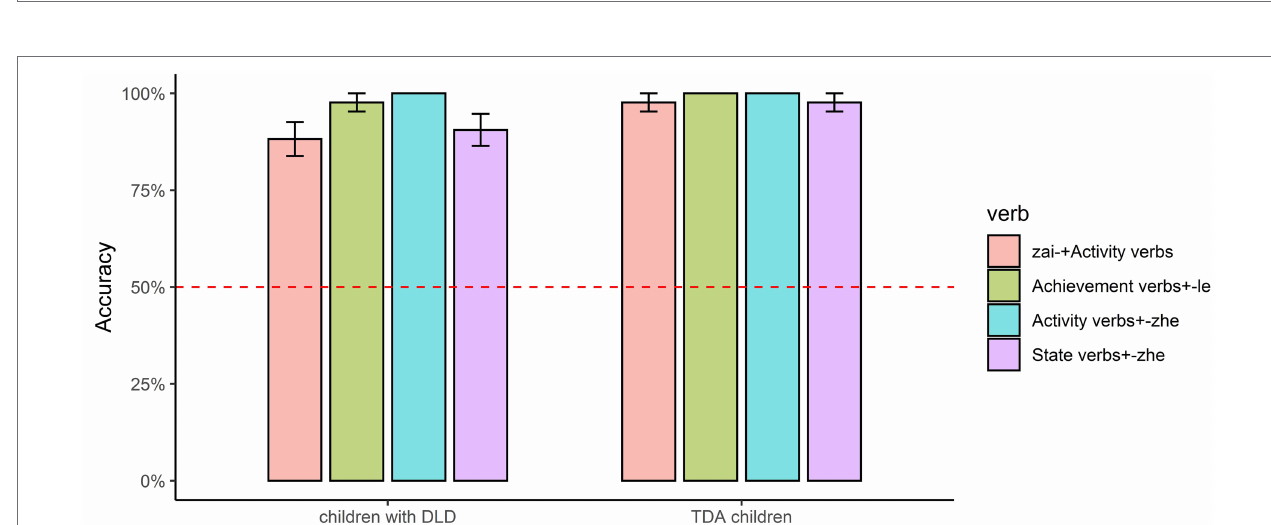
FIGURE 6 | Accuracies for the prototypical combinations of aspect markers with